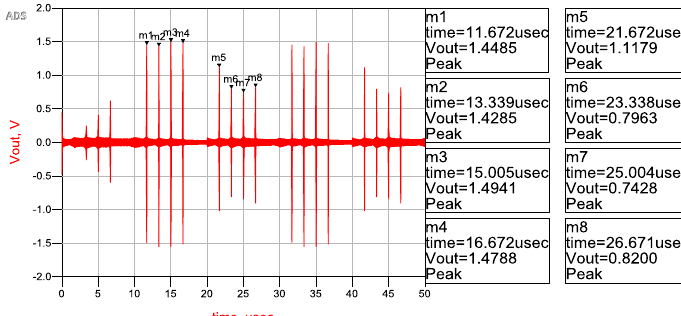
Figure 9. Output pulses of the single-channel system with four input frequencies of the model with nonideal